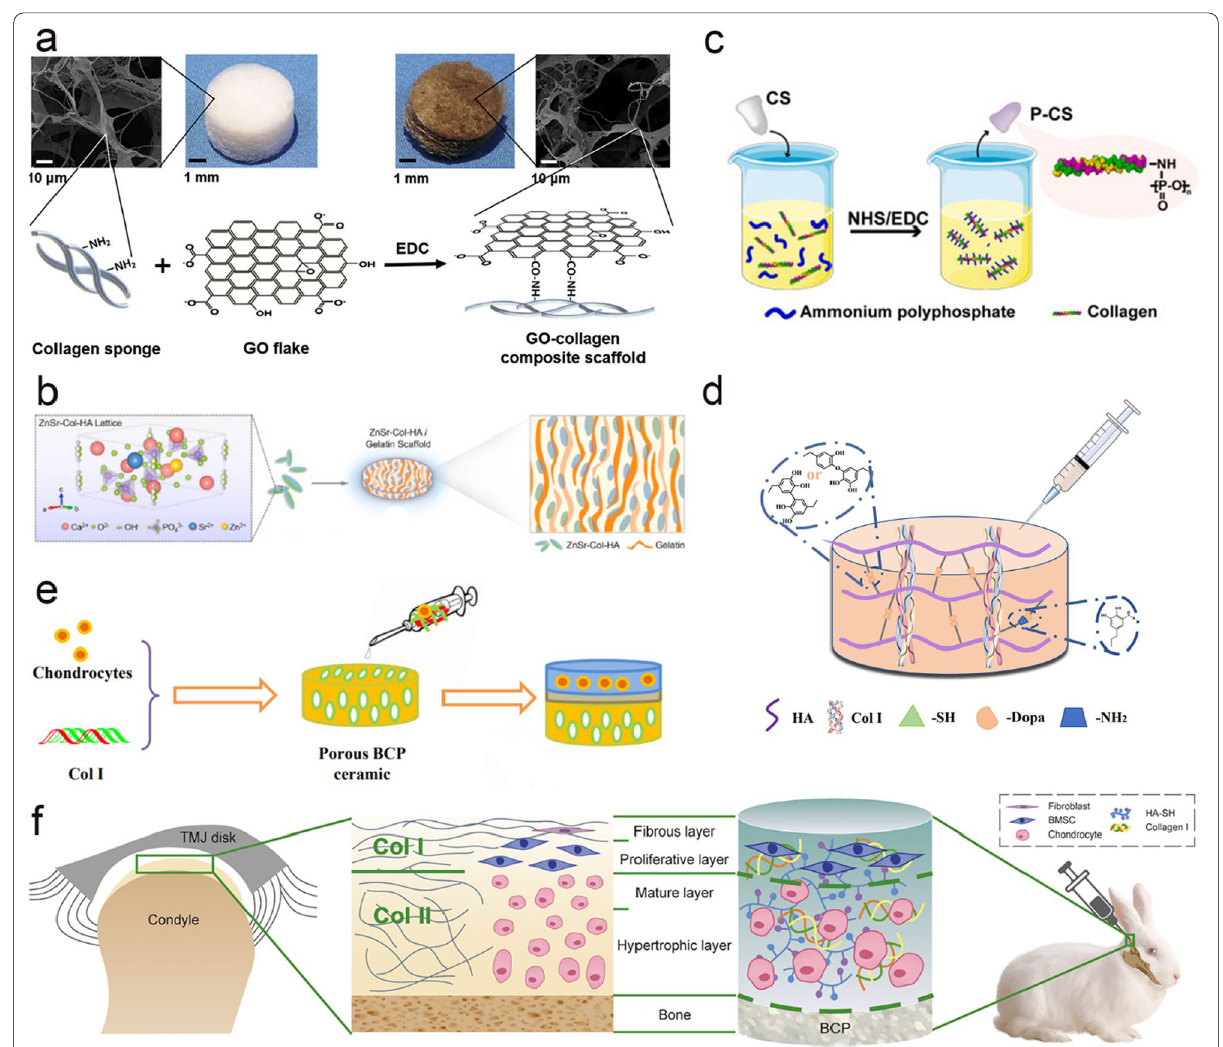
Fig. 6 Application of collagen in bone/cartilage repair. a A schematic illustrating the covalent conjugation of the carboxyl groups of GO flakes to the amine groups of the collagen scaffolds. Reproduced with permission from [109]; b Synthesis of a Zn/Sr ion doped collagen scaffold co-assembled hydroxyapatite to promote osteogenic differentiation of BMSC. Reproduced with permission from [110]; c Polyphosphate-cross-linked collagen scaffold used in treatment of post-extraction bleeding and alveolar bone loss after tooth extraction. Reproduced with permission from [113]; d Preparation of polysaccharide/collagen hydrogel with BMSC recruitment function for cartilage repair. Reproduced with permission from [120]; e A new bi-layer scaffold containing Col I and BCP ceramics for regeneration in osteochondral defects. Reproduced with permission from [121]; f An injectable self-crosslinking thiolated HA-SH/Col I blend hydrogel and BCP ceramics combined with rabbit bone mesenchymal stem cells (rBMSCs)/chondrocytes used to fabricate a new bi-layer scaffold for the repair of rabbit condylar osteochondral defects. Reproduced with permission from